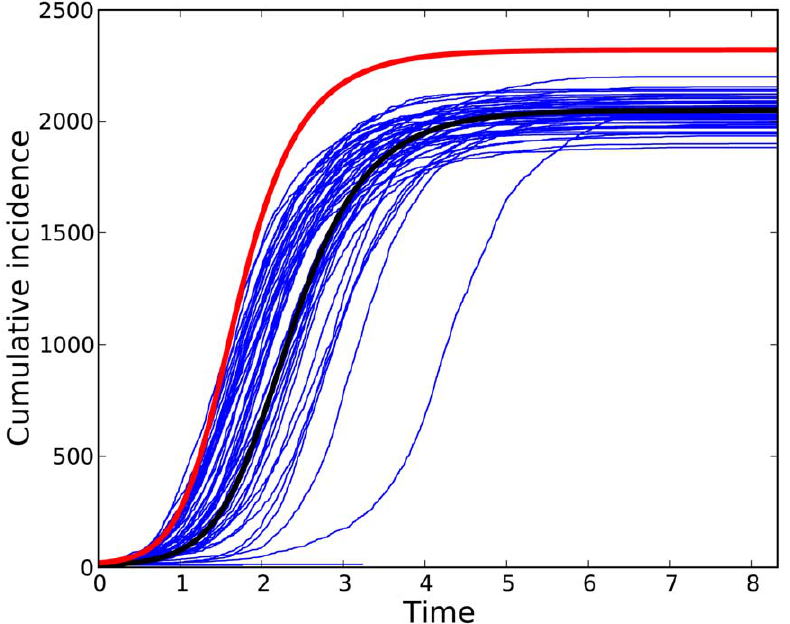
Figure 2. Cumulative number of infections through time. Fifty stochastic simulations (blue dashed lines) are compared to the solution of equations(black line)13–17. Thedegree distributionisgenerated by equation29 with p ~ 2 = 3 and r ~ 1 = 2 . N ~ 5000, I (0) ~ 10, p t ~ 0 : 9, b ~ 1 : 5, and c ~ 1 . For comparison, a trajectory with p t ~ 0 is shown in red.